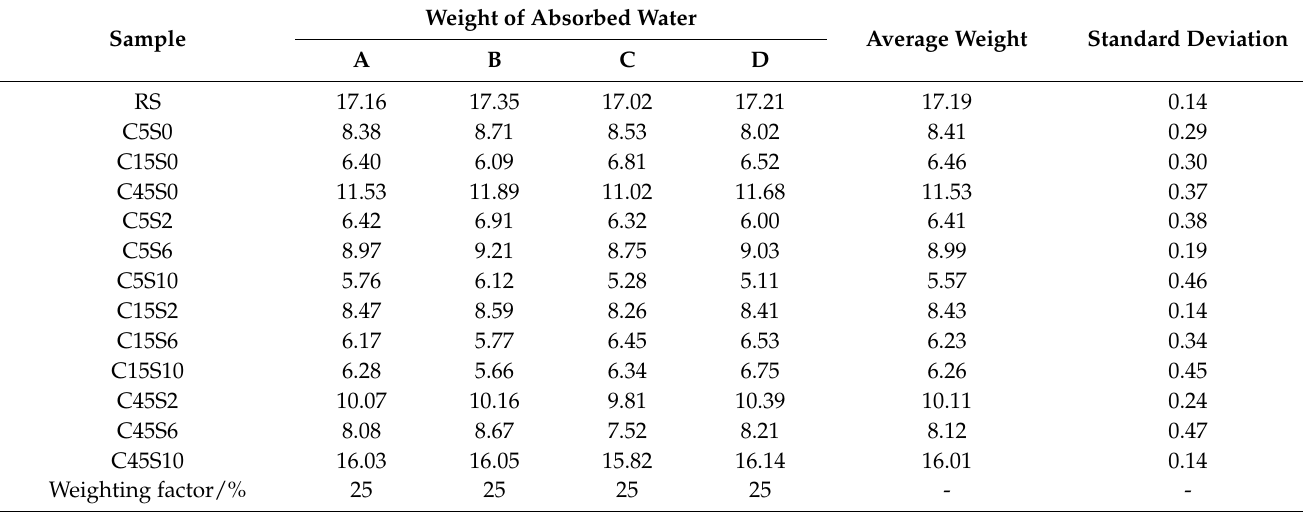
Table A5. Original data of absorbed water weight in water absorption test (unit: